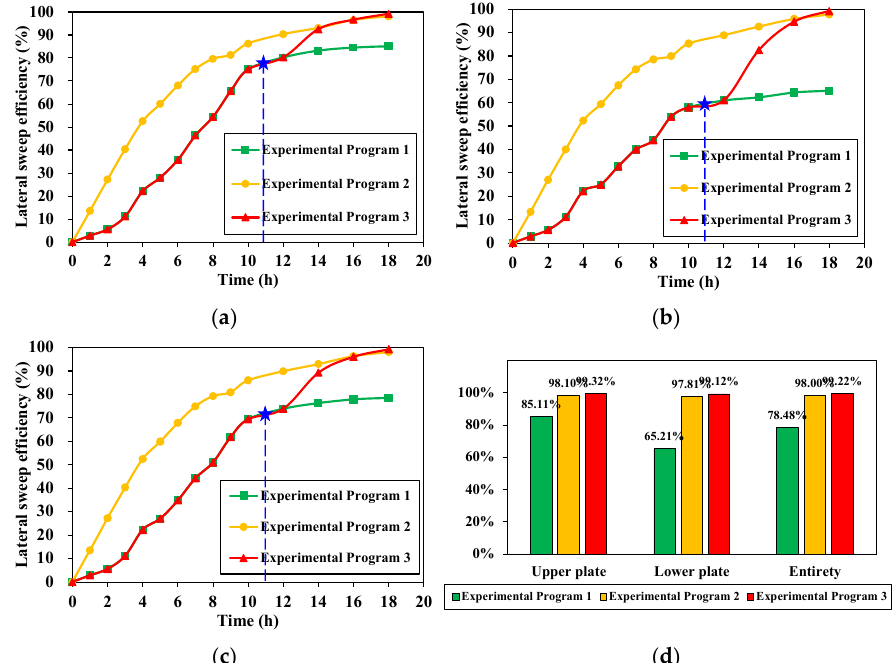
Figure 9. Quantitative evaluation of the spread coefficient of different experimental conditions; ( a ) plane sweep coefficient-time curve of upper plate; ( b ) plane sweep coefficient-time curve of lower plate; ( c ) overall plane sweep coefficient-time curve; ( d ) comparison histogram of limit spread of each Experimental Program. The blue dotted lines represent the cyclic alternating injection and production timing in Experimental Program 3.